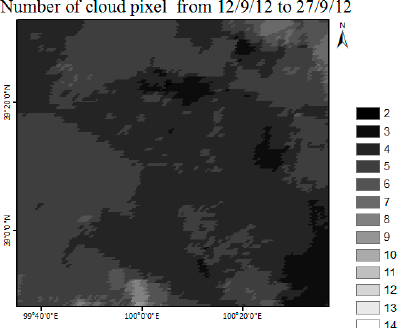
Figure 10. The accumulation of cloudy pixels during the retrieval period (12–27 September 2012).